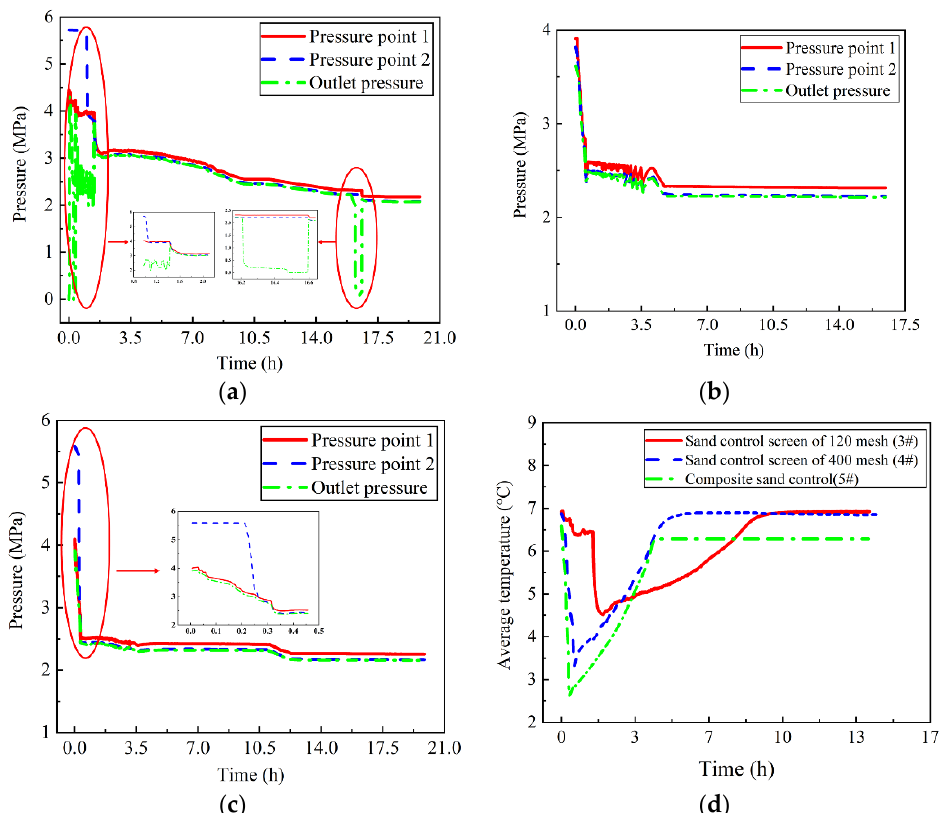
Figure 11. ( a ) Pressure change diagram of 120 mesh sand-control screen in radial well depressurization; ( b ) Pressure change diagram of 400 mesh sand-control screen in radial well depressurization; ( c ) Pressure change diagram of 120 mesh sand-control screen + gravel packing in radial well depressurization; ( d ) Change diagram of average temperature in radial well depressurization with different sand control methods.